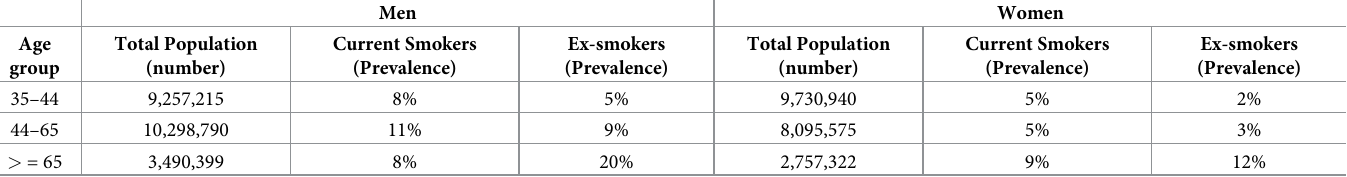
Table 1. Total population and smoking prevalence by gender and age groups in Nigeria (GATS 2012,